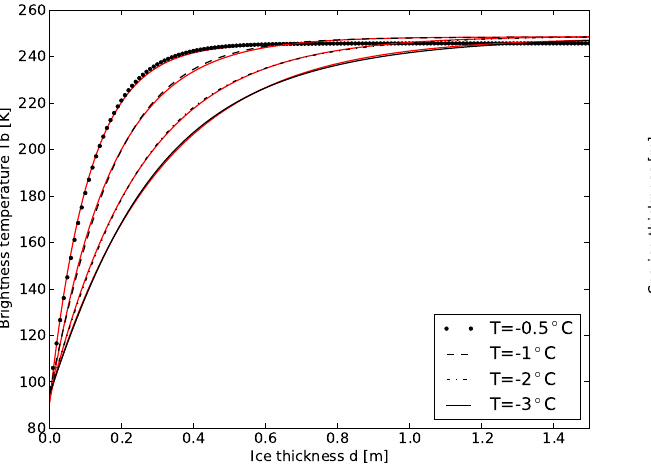
Fig. 2. Nadir 1.4GHz brightness temperature of Baltic sea-ice ( S = 0 . 65, roughness σ d = 0 . 1 d ) for different ice temperatures. The results of the semi-empiric model (Eq. 9) are indicated with the red lines.